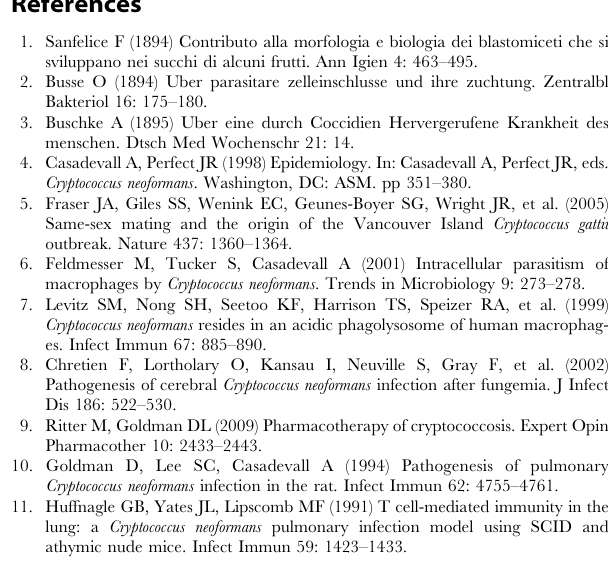
Figure S2 Effect of modulation of either PKD 1 or PKD 2 on HL-60 cell differentiation. Two million HL-60 cells were transfected with 4.5 m g of SCR, PKD1 siRNA, PKD2 (PKD2.2) siRNA by nucleofection. Differentiation was induced with DMSO and RA. Cells were collected at 48 hours and processed for flow cytometry analysis of CD11b positive cells. Results are represen- tative of at least 3 independent experiments, and error bars represent SD and * P , 0.05 compared with SCR undifferentiated cells. UD, undifferentiated; D, differentiated cells.